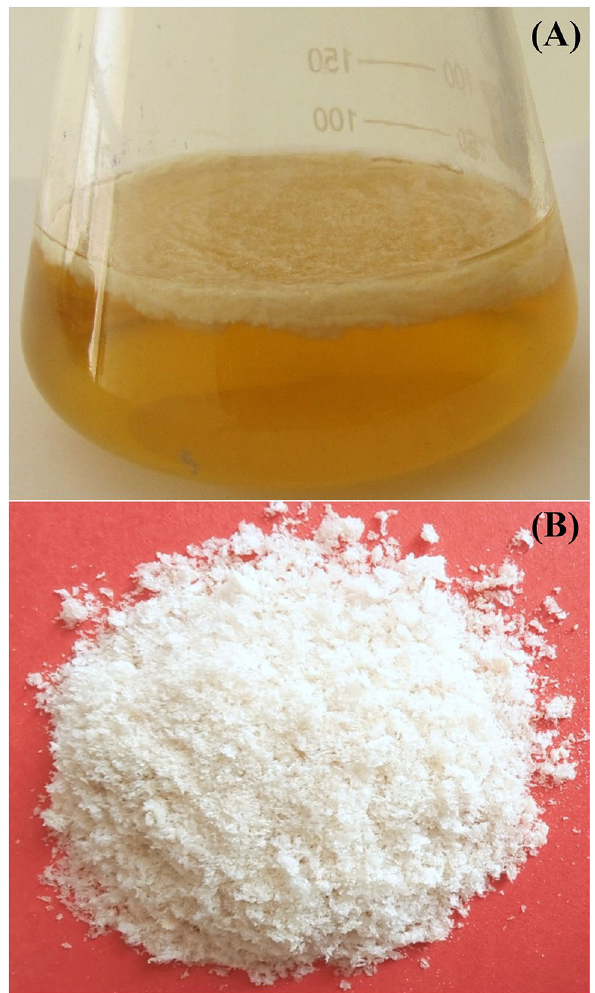
Figure 1. ( A ) Bacterial cellulose layer produced at the air–liquid interphase on medium no. 1; ( B ) Purified powder of the